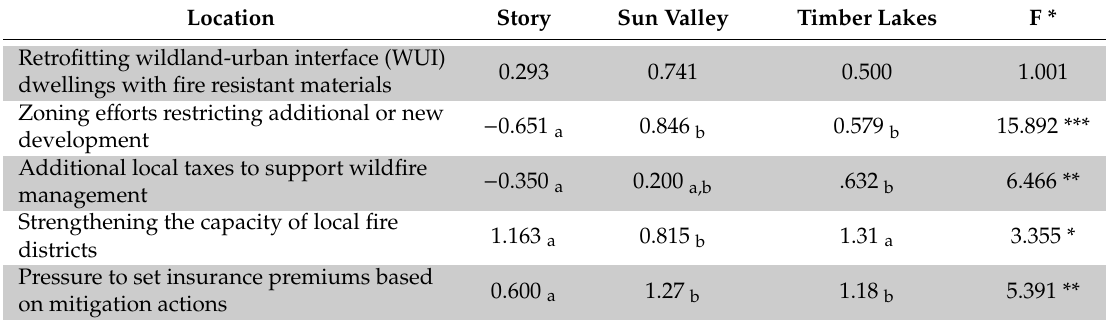
Table 4. Mean ratings of strategy e ff ectiveness or ine ff ectiveness in promoting fire adaptation among participants in case study locations. All ratings were coded with scores ranging from − 2 to